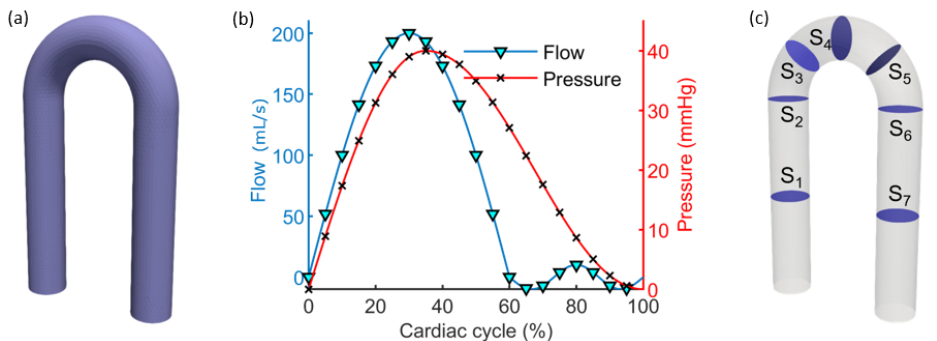
Figure 3. ( a ) Rendering of the U-shaped model; ( b ) Flow and pressure boundary conditions applied to the inlet and outlet of the U-shaped model; ( c ) Visualization of the seven cross-sections defined for the U-shaped